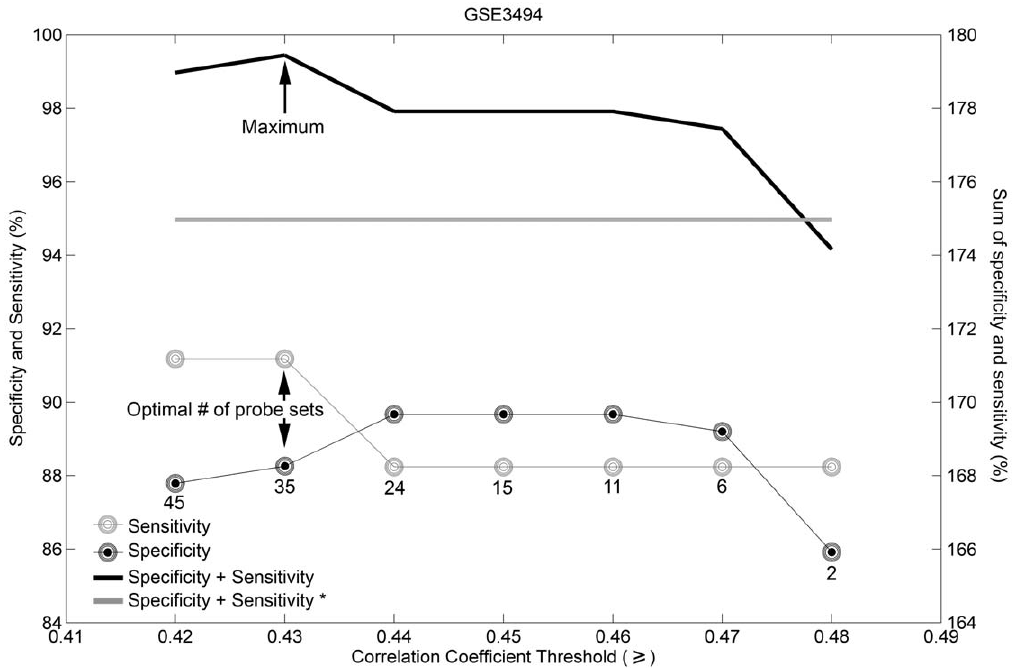
Figure 1. Selecting gene signature predictive of ER status based on sensitivity and specificity. The cutoff is based on Spearman rank correlation coefficients. The number of probe sets in each signature is marked by the number under the lowest curve. Black filled circles – specificity; gray circles – sensitivity; black line – sum of specificity and sensitivity. The optimal number of probe sets was 35, with Spearman rank correlation coefficient cutoff set at 0.43. Gray line and ‘‘*’’ indicate the sum of specificity and sensitivity of the prediction obtained by using a single ‘‘best probe set’’ (‘‘205225_at’’).